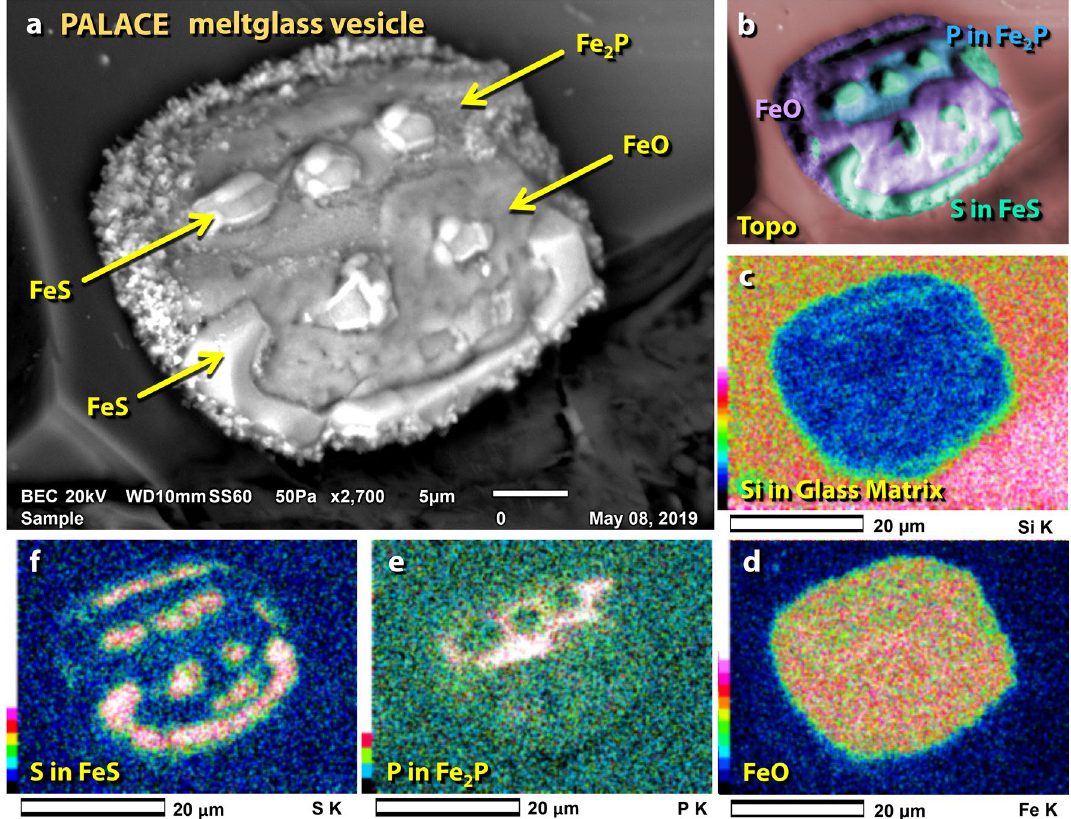
Figure 40. SEM images of Fe-S-P-enriched nugget in vesicle of mudbrick meltglass from the palace. ( a ) Chemically complex nugget inside a vesicle; contains Fe, S, and P. ( b ) Manually constructed EDS-based phase map showing that nugget is dominantly composed of Fe oxides, S as FeS, and P as Fe 2 P. ( c )–( f ) SEM–EDS elemental maps showing the composition of nugget by regions.